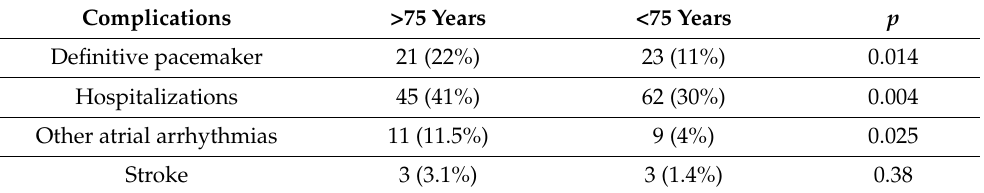
Table 5. Complications.